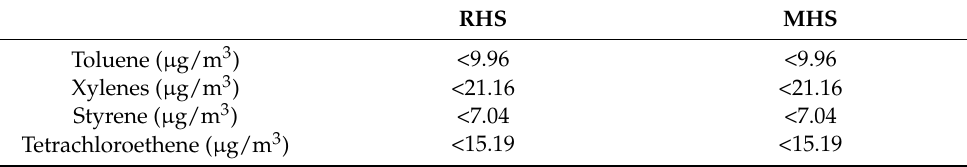
Table 7. Results of VOC measurements in indoor air with different heating